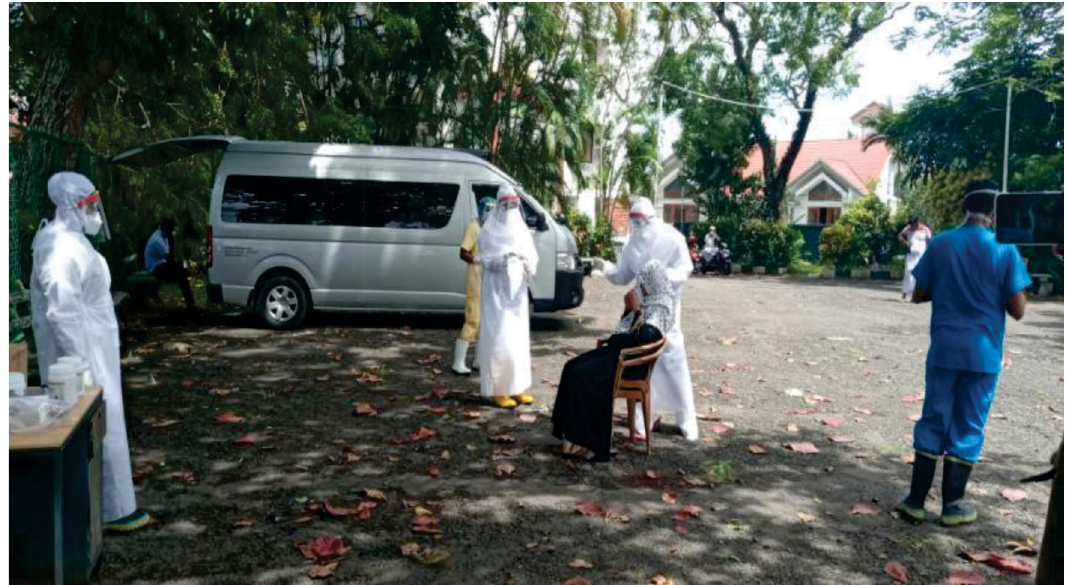
Figure 1: Obtaining a sample for PCR testing at NIHS Field Practice Area Achievements There have been 57 COVID-19 cases identified and 214 subjected to PCR testing up to 29 April 2020. The summary of main indicators related to disease control at NIHS FPA is shown in Table 1.